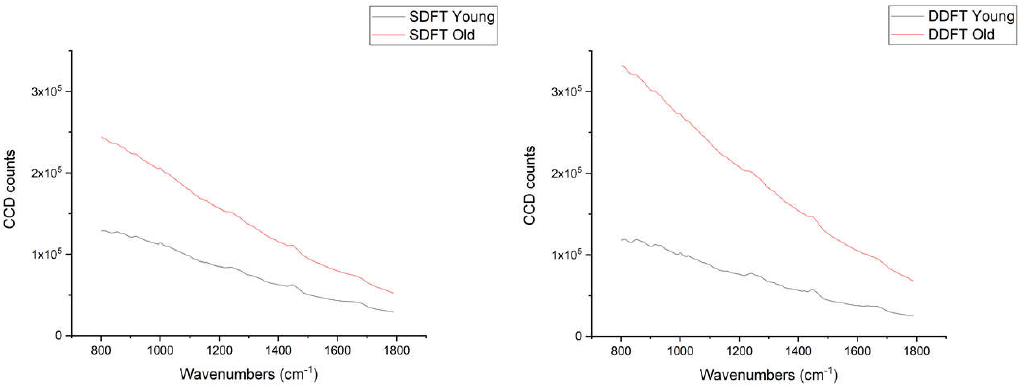
Figure 1. Averaged charge-coupled device (CCD) counts of young (40 spectra) and old (30 spectra) superficial digital flexor tendons (SDFTs, Left ) and deep digital flexor tendons (DDFTs, Right ) (40 spectra in both groups).